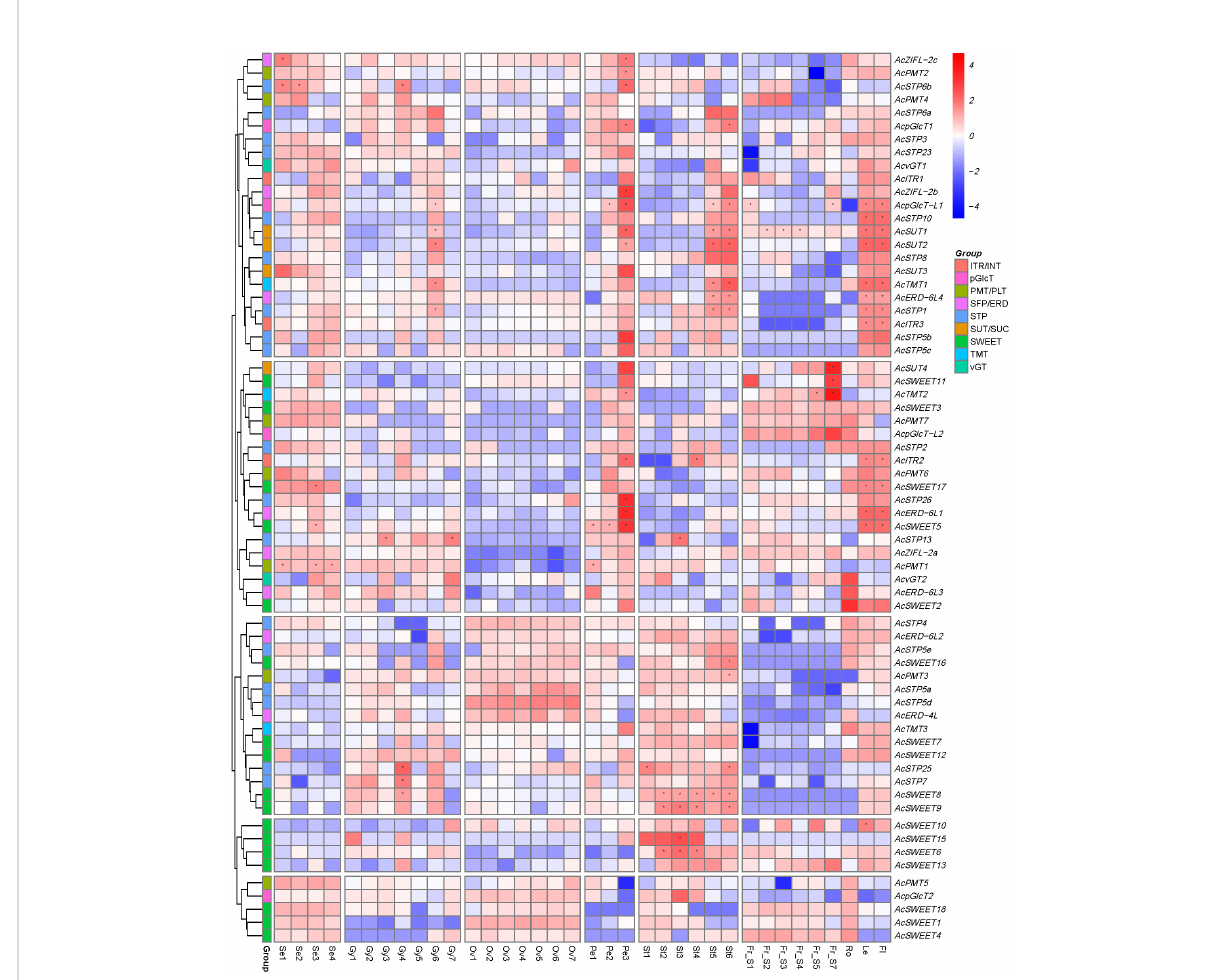
FIGURE 7 Expression pro fi le of pineapple sugar transporter genes during different stages of reproductive development. The heatmap was created based on the log2 (TPM + 0.01) value of the genes and normalized by row. Red color represents a high transcript abundance, and blue represents low transcript abundance, and asterisks (*) represent the FKM values above 100. The right side of the fi gure shows the scale. Details of the samples are mentioned at the bottom of each lane: sepal Se1 – Se4, gynoecium Gy1- Gy7, ovule Ov1 – Ov7, petal Pe1 – Pe3, stamen St1 – St6, fruit ‘ Fr_S1 – Fr_S7 ’ , where ‘ S ’ is the abbreviation for ‘ stage ’